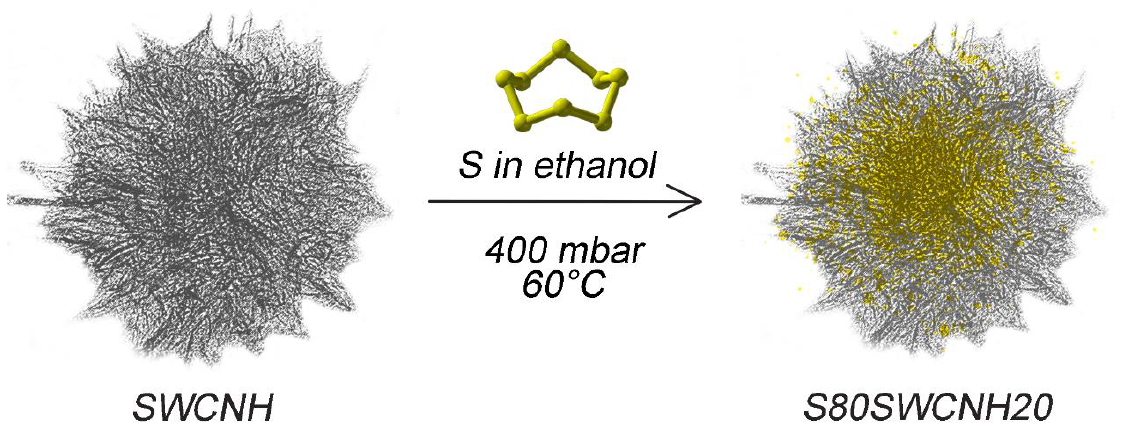
Figure 1. Schematic illustration of the active − material synthesis process.